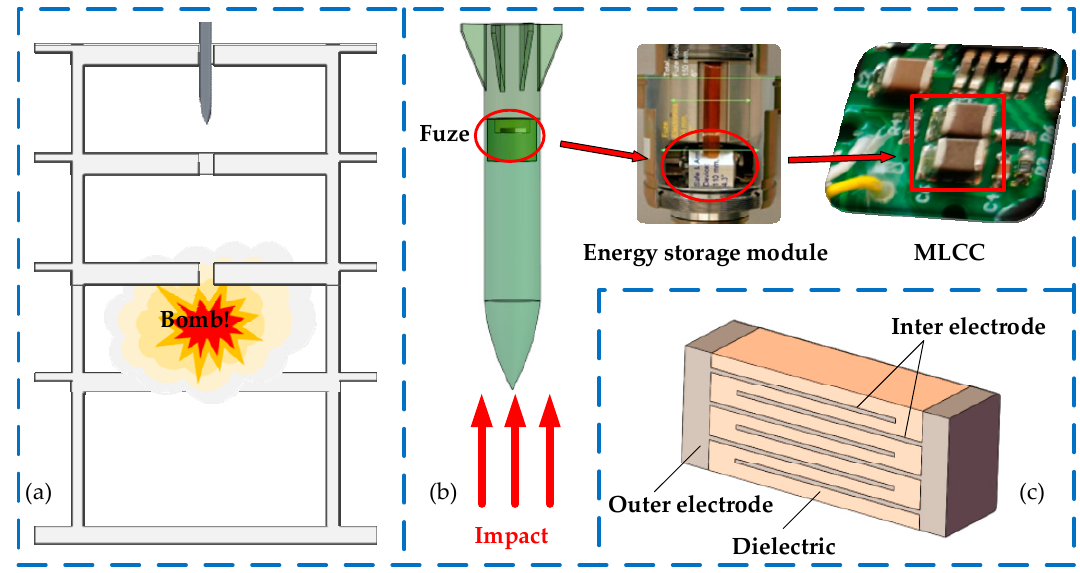
Figure 1. Application of a multilayer ceramic capacitor (MLCC) in a penetration weapon. ( a ) The penetration process in a military application. ( b ) The MLCC is the energy-storage element of a penetration fuze. ( c ) Internal structure diagram of the MLCC .